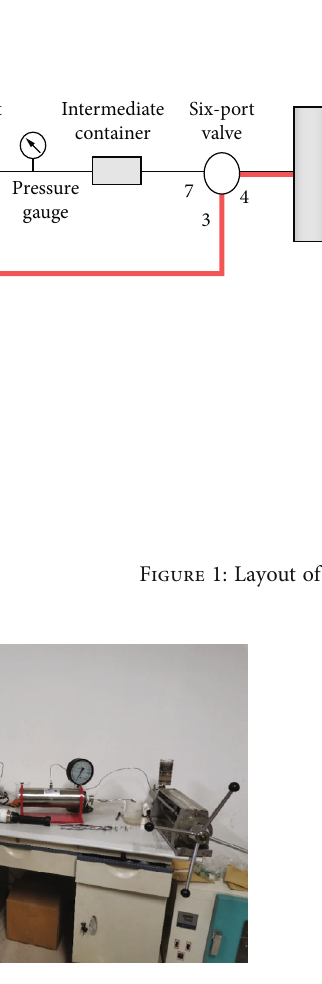
Figure 2: Object pictures of experimental instruments.